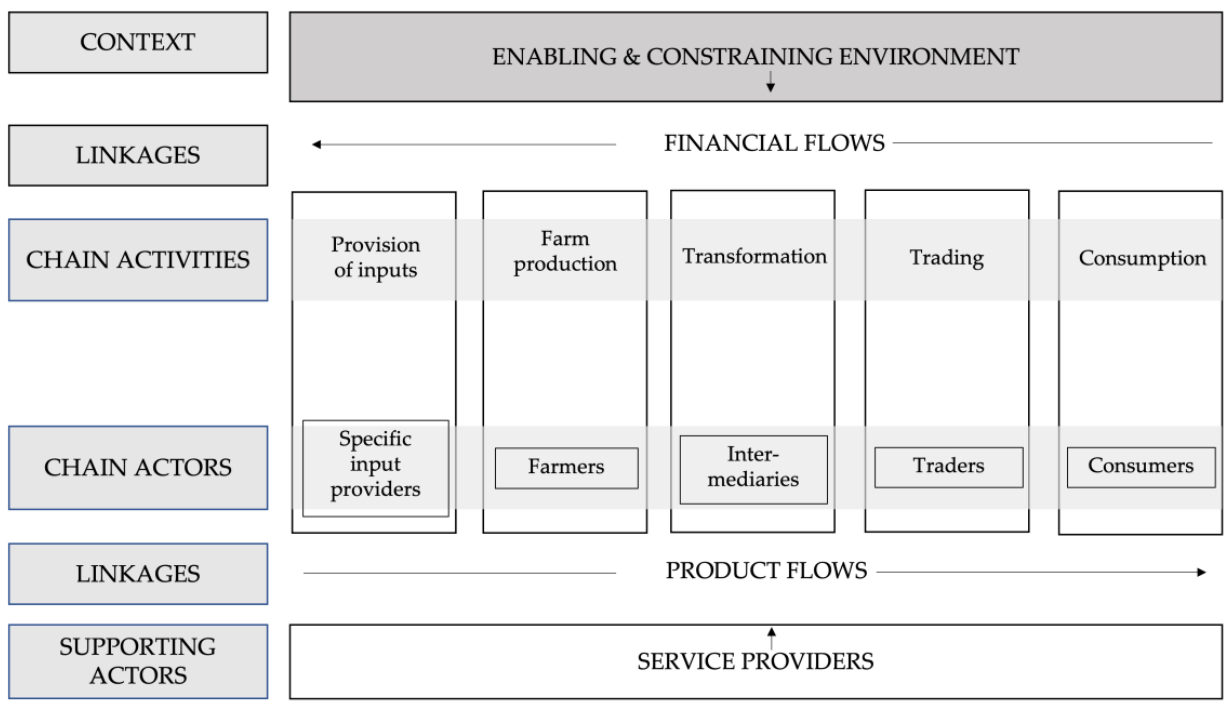
Figure 2. The structure of a value-chain mapping canvas